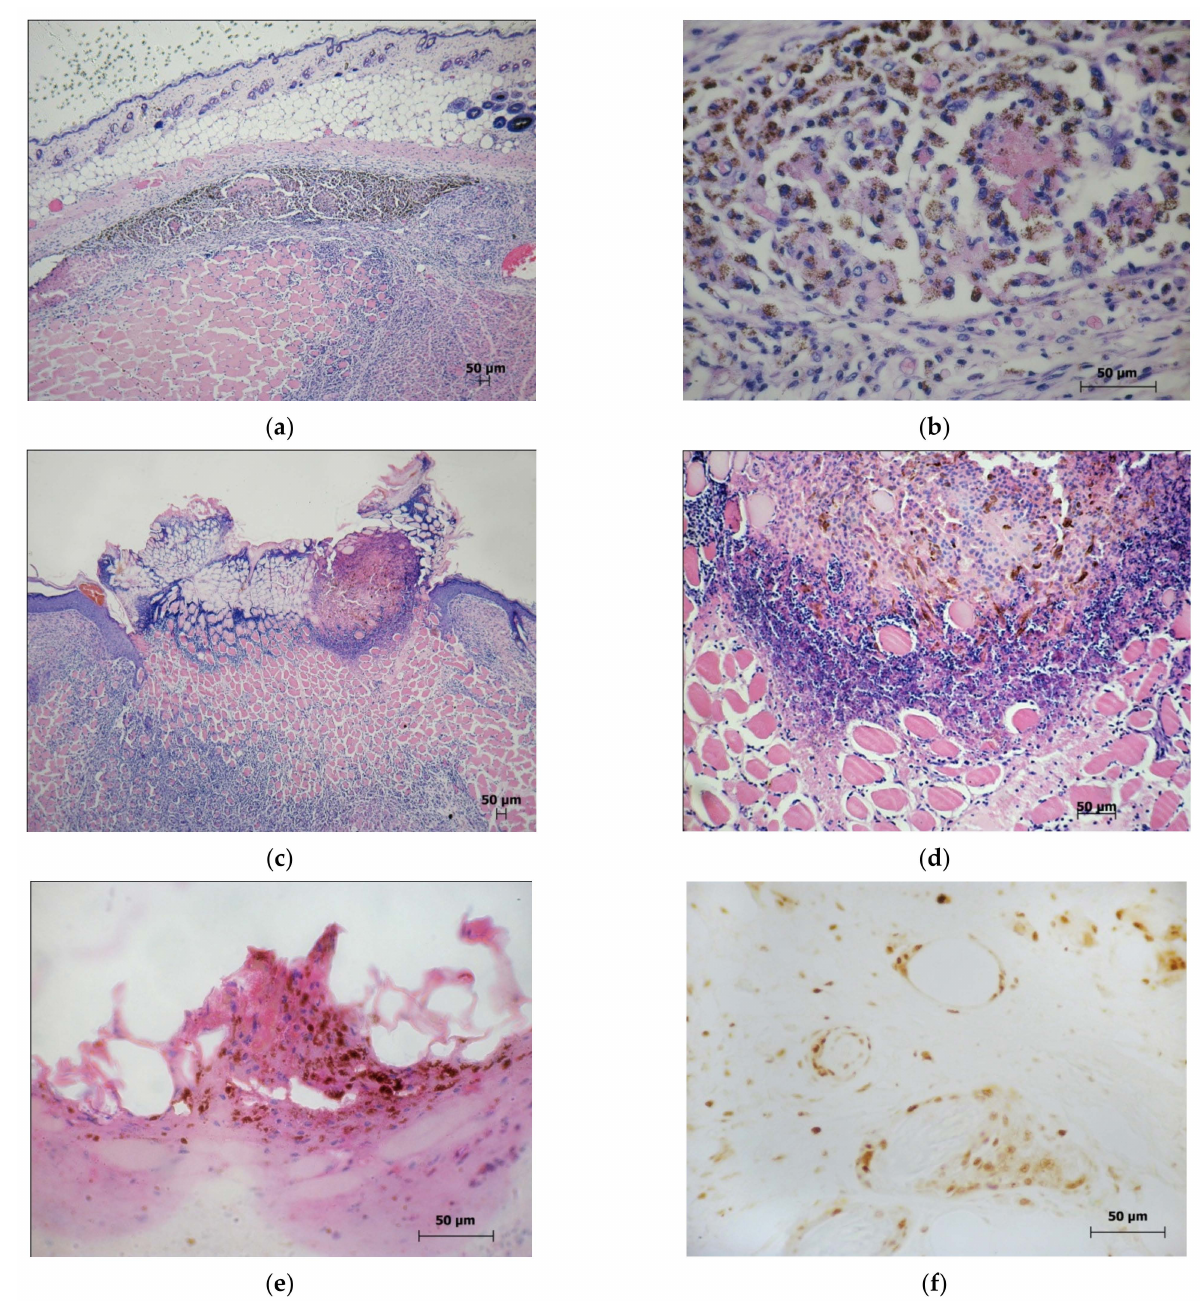
Figure 5. The zone of the laser exposure on the 21st day after the PDT. Experimental group 2: ( a ) Skin healing and melanin-containing macrophages in the zone of elimination of the tumor detritus. Staining with hematoxylin and eosin. × 5; ( b ) Fragment. The melanophages in the area of the melanoma photodestruction. Staining with hematoxylin and eosin. × 40; ( c ) The stroop in the PDT zone. Staining with hematoxylin and eosin. × 5; ( d ) Fragment. Staining with hematoxylin and eosin. × 20; ( e ) The eschar containing the tumor detritus. Staining with hematoxylin and eosin. × 40; ( f ) A PCNA-positive reaction of the nuclei of the endothelial cells and the connective tissue of the perineurium. ×